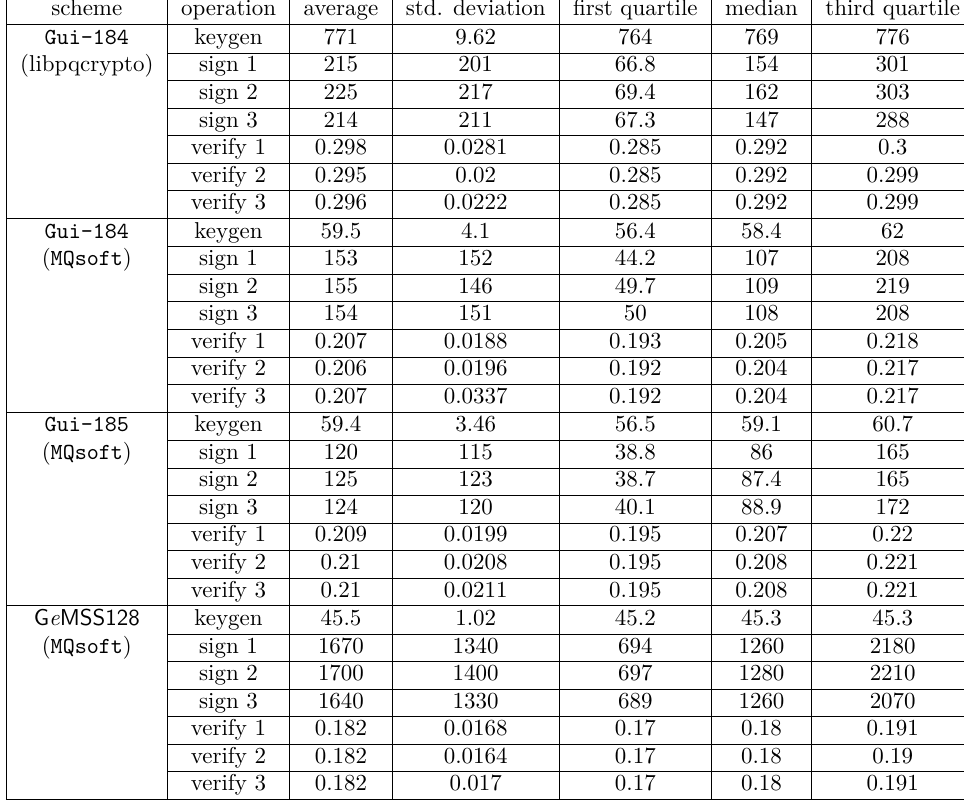
Table 20: Statistics in mega cycles (Mc) for each cryptographic operation, for a Skylake process (LaptopS). For three different keypairs, documents of length 59 bytes are signed then verified. The EUF-CMA property is implemented for all